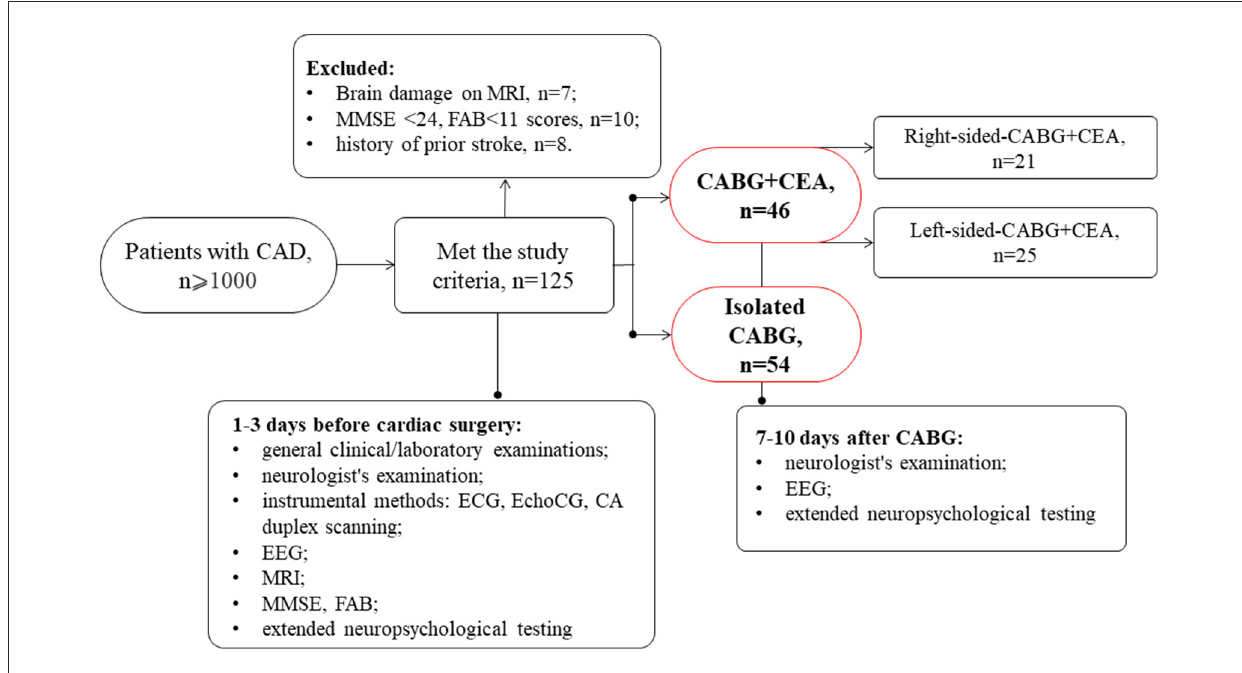
FIGURE1 Design of the